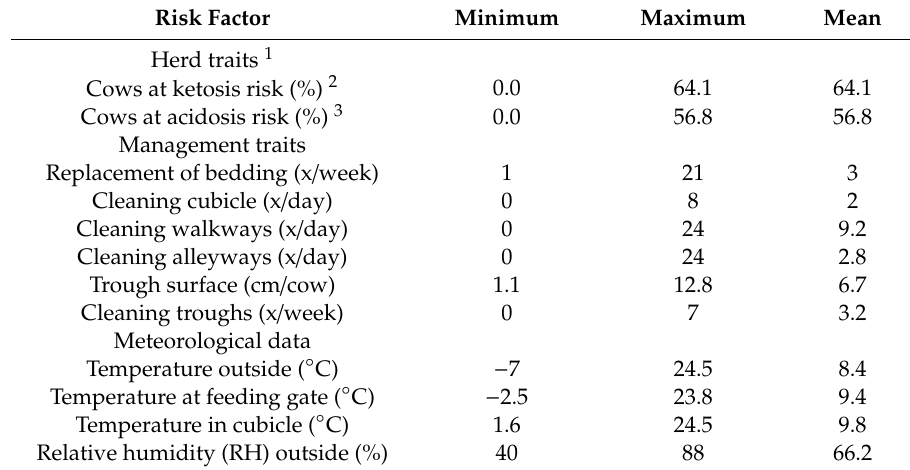
Table A1. Farm-level associated risk factors and their mean, minimum and maximum values considered in the univariate analysis of their associations with teat-skin bacterial loads of aerobic mesophilic counts, esculin-positive streptococci and coliform